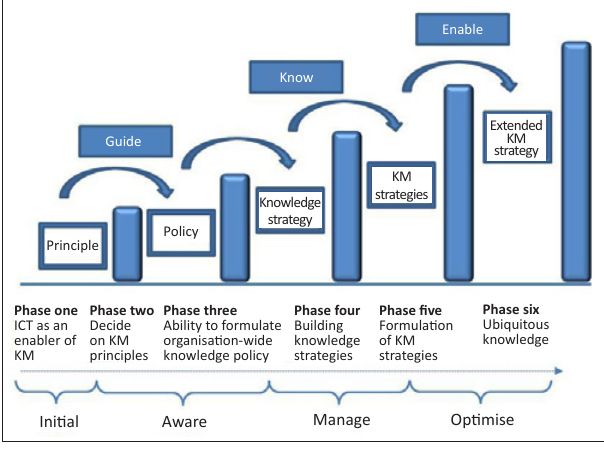
FIGURE 3: Multi-membership learning cycle of CoPs.